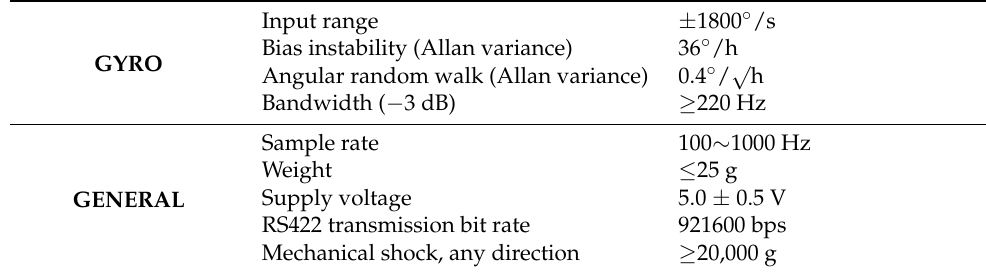
Table 1. Specifications of MSI320H